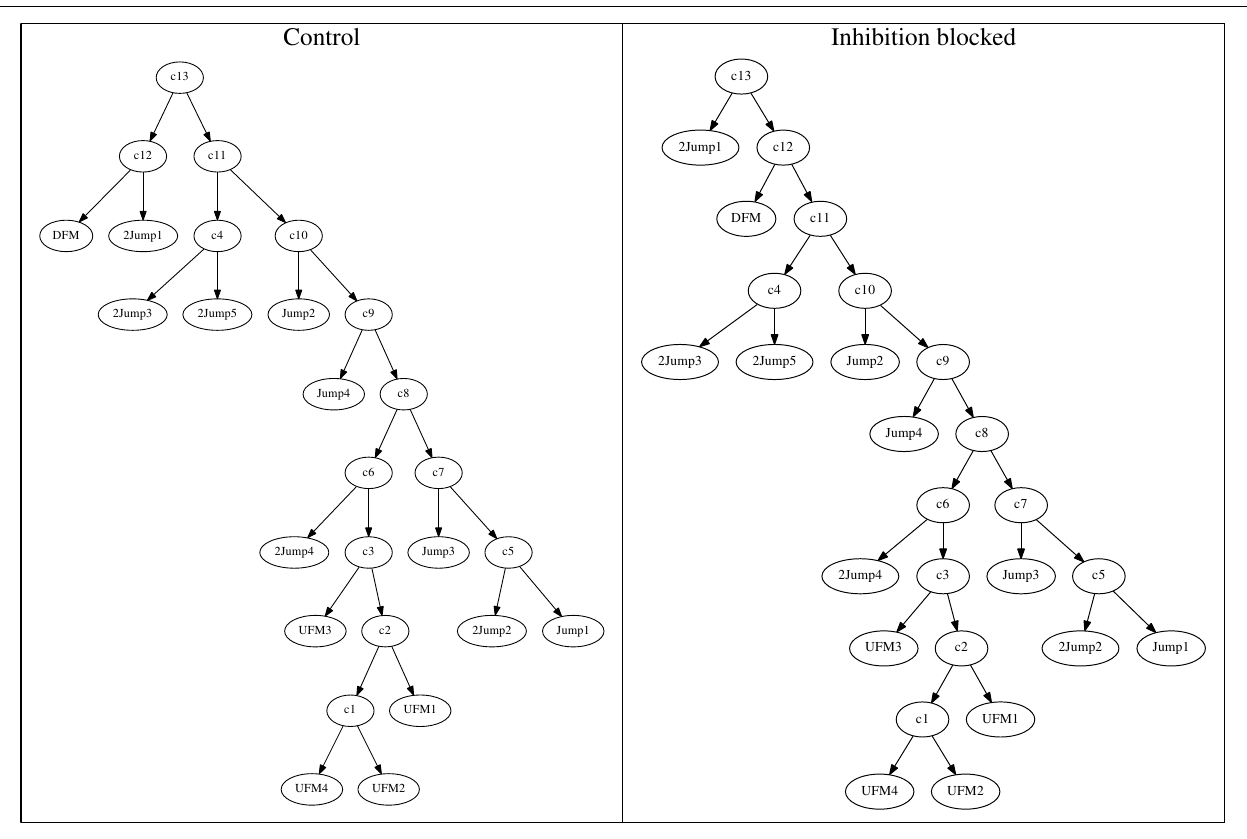
FIGURE 10 | Consistent consensus trees under control (left panel) and inhibition-blocked (right panel) conditions, for the neuron shown in Figure 8. The two clustering trees are essentially identical. The only